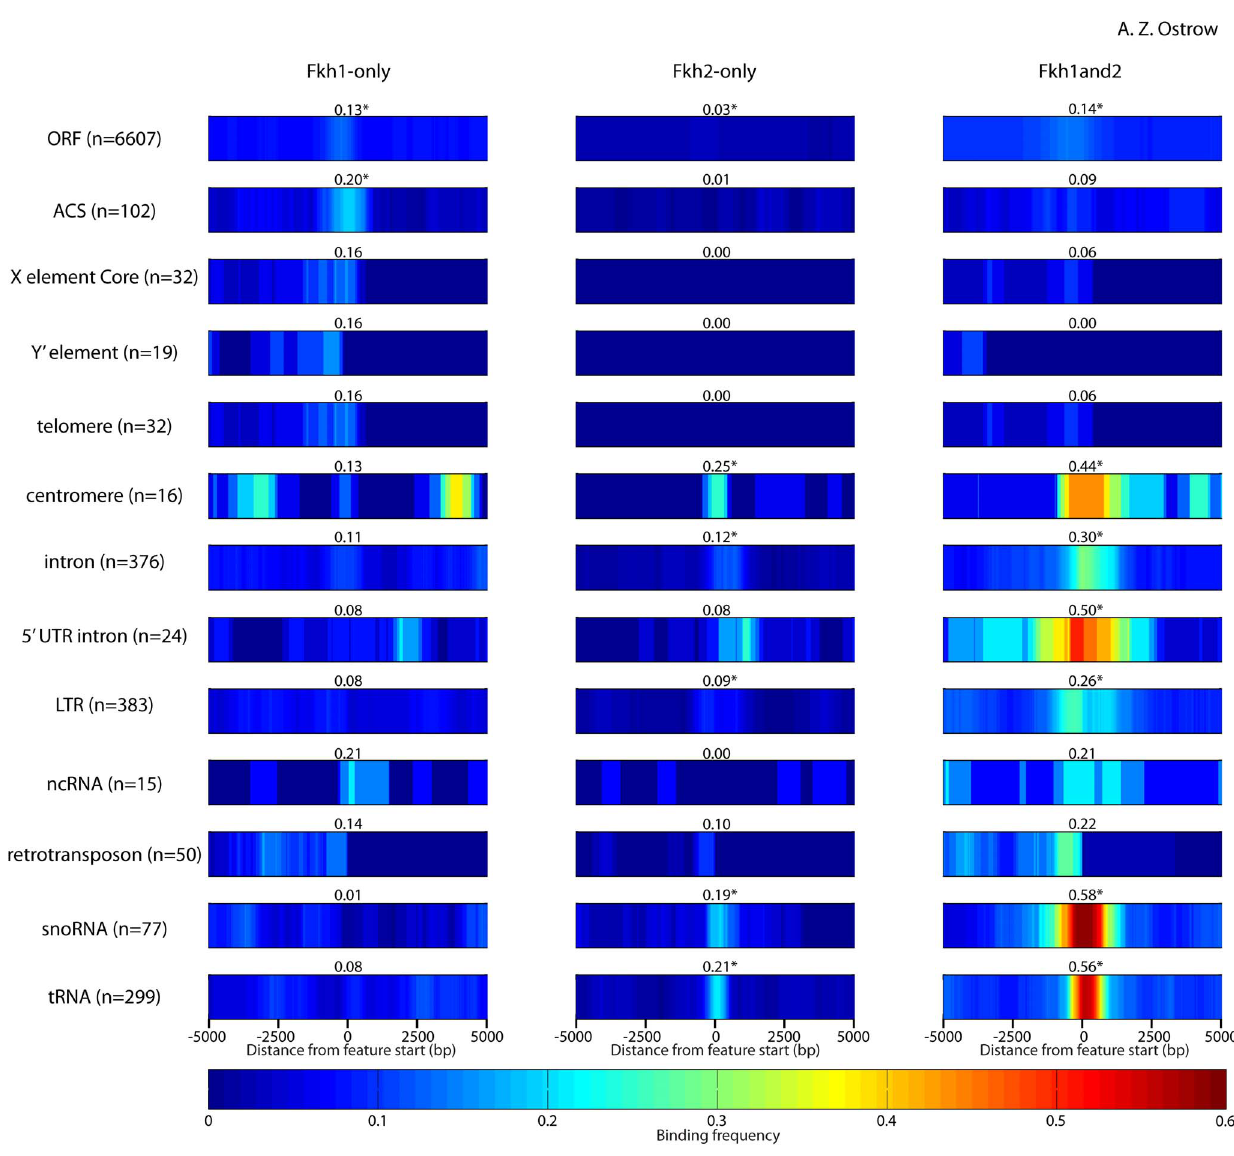
Figure 6. Analysis of Fkh1 and Fkh2 binding proximal to various genetic elements. Fkh1 and Fkh2 enrichment frequencies surrounding different classes of genetic elements are oriented and aligned at coordinate 0 according to the first base position of each element. The maximum frequency reached within 100 bp (500 bp for Y 9 ) of coordinate 0 is indicated above each heat map. The asterisk indicates significant enrichment (p , 0.001) near coordinate 0 (see Methods